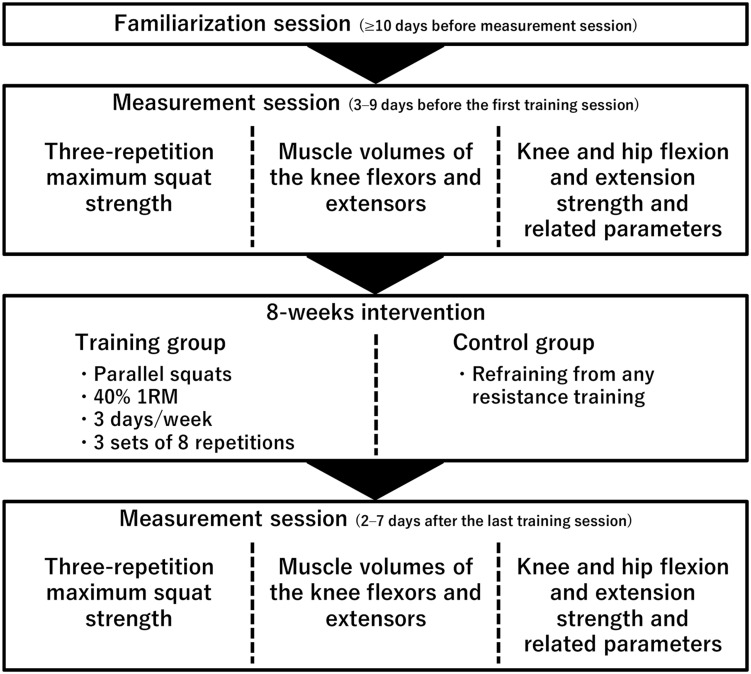
Schema of experimental procedures.